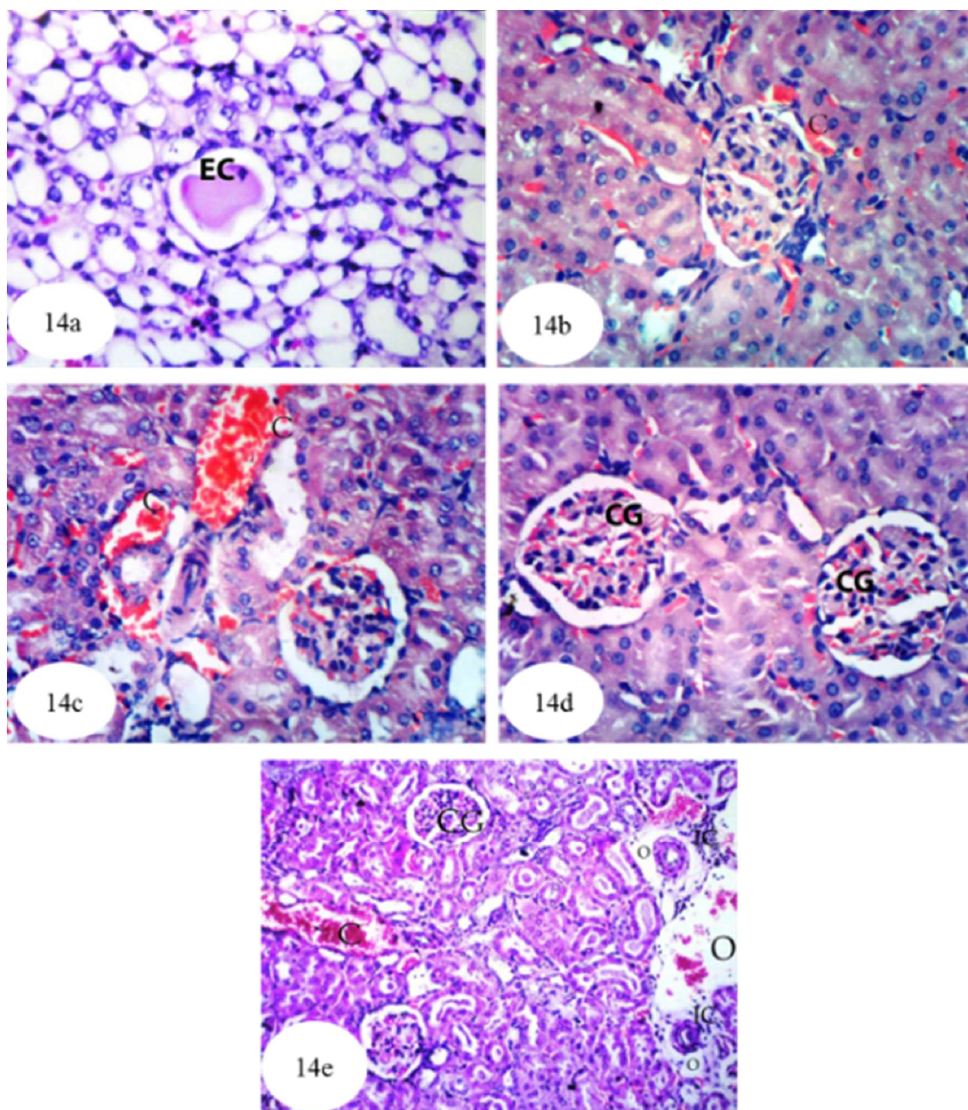
Figure 14. Photomicrographs of hematoxylin and eosin stained sections of kidney of ethylene glycol-administered rat treated with P. ostreatus aqueous extract showing homogenous eosinophilic casts (EC) in the lumen of few medullary tubules ( a ) (×256), slight congestion (C) of intertubular blood capillaries ( b ) (×400); congestion (C) of intertubular blood vessles ( c ) (×400); slight congestion of the glomrular tufts (CG) ( d ) (×400); and congestion (C) in the cortical blood vessels and glomeruli (CG) with perivascular inflammatory cells (IC) infiltration and oedema (O) ( e ) (×128).